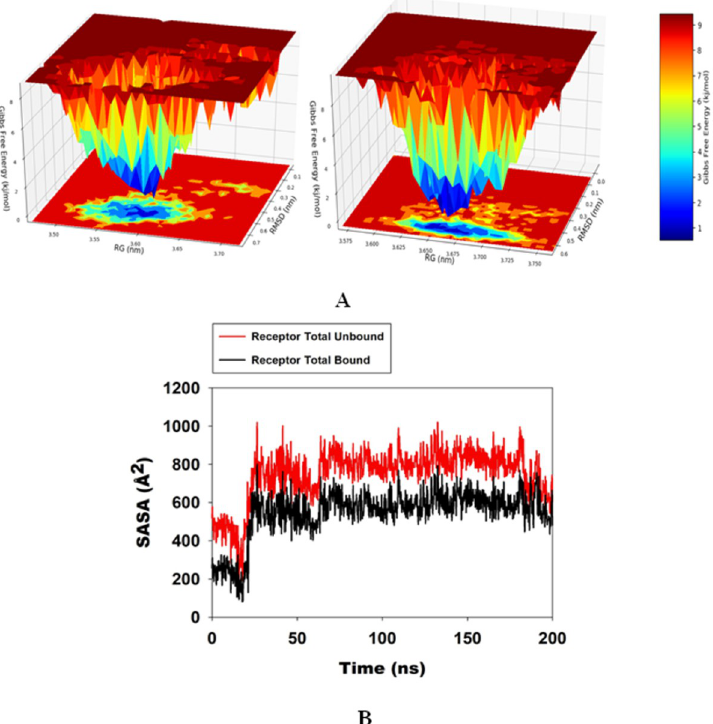
Fig 7. A. Free Energy Landscape displaying the achievement of global minima ( Δ G, kj/mol) of (P) 2ALA in presence of Lupenone with respect to their RMSD (nm) and Radius of gyration (Rg, nm); B. SASA of bound and unbound state.